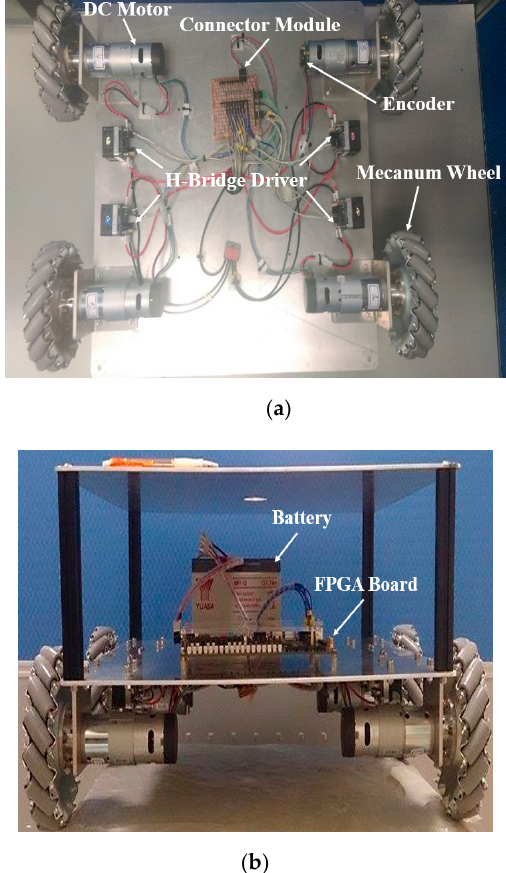
Figure 3. Field-programmable gate array (FPGA)-based mechatronic design of the proposed omni- Mecanum-wheeled autonomous vehicle ( a ) Bottom view ( b ) front view.